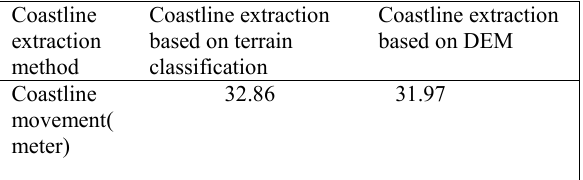
Table 4. Comparison of coastline movement extracted by two